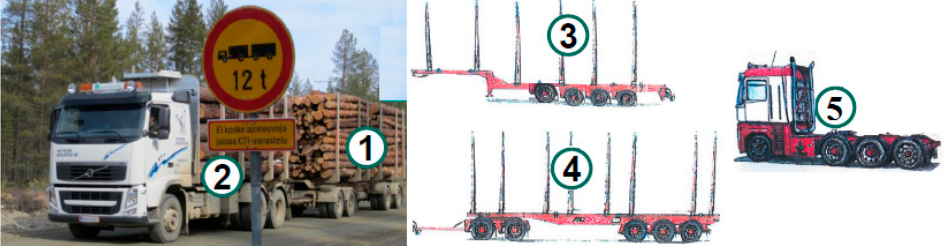
Figure 5. The group transportation method of timber. A 64 t vehicle operates on forest roads for delivering a fully loaded trailer ( 1 ) from forest to local terminal, and loads ≥ 76 t vehicles ( 3,4,5 ) from truck ( 2 ) or terminal’s piles, and takes an empty trailer ( 4 ) back to forest; ≥ 76 t vehicles deliver loads from terminals to mills.